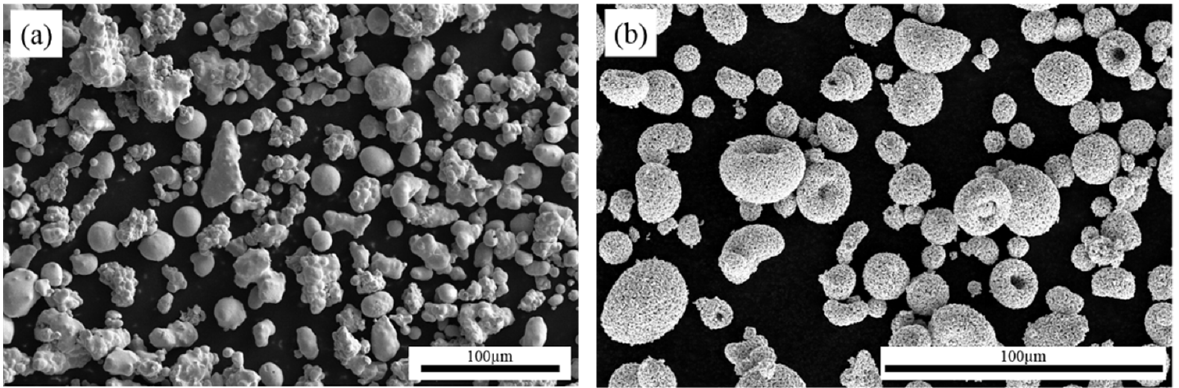
Figure 1. The morphology of Cu powder ( a ) and Mn 1.5 Co 1.5 O 4 powder ( b ).